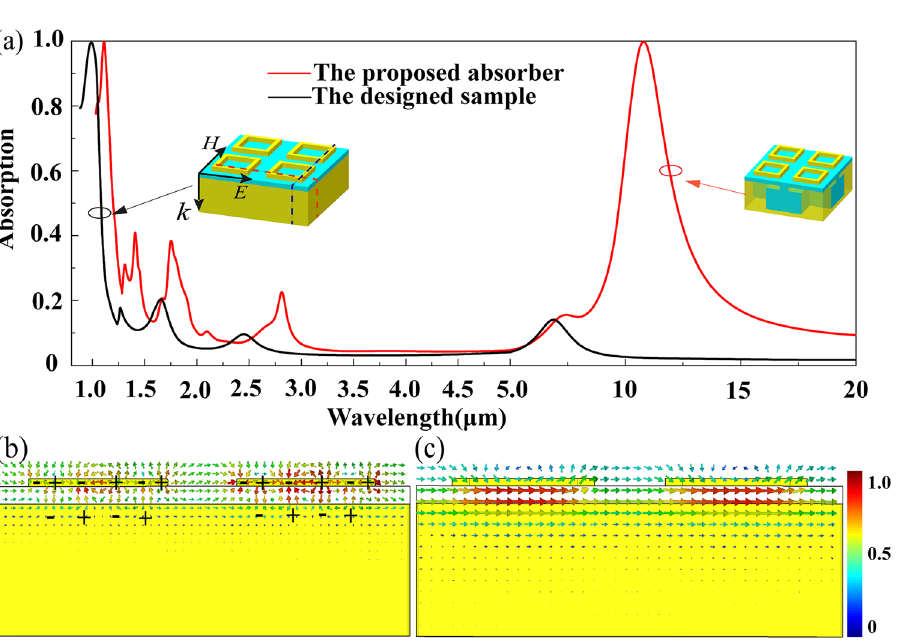
Figure 3. Sketch map interpreting the absorption peak at 1.064 μ m. ( a ) Absorption spectrum of the designed absorber (red line) and a new sample (black line) under normal incidence. The red and black dotted lines on the new sample show the positions of cross section view for ( b ) Electric field distribution and ( c ) Magnetic field distribution at 0.989 μ m,